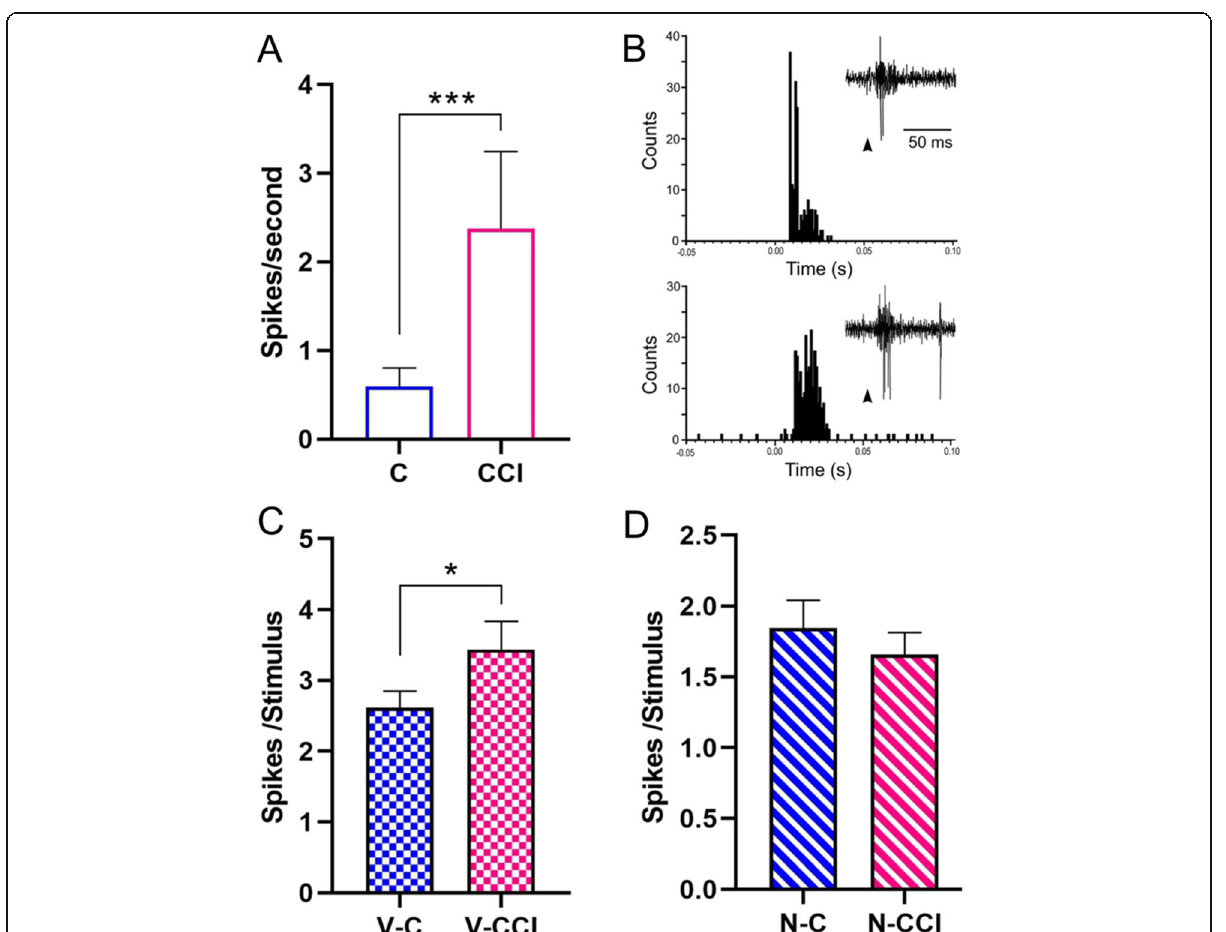
Fig. 3 Changes in spontaneous and input-evoked activity of TCC neurons after CCI-IoN. ( a ) Frequency of spontaneous discharges increased four- fold in CCI-IoN animals (C, control group; CCI, CCI-IoN group). ( b ) Representative PSTHs of vibrissal responses (50 stimuli) in a control case (upper plot) and in a CCI-IoN rat (lower plot). Insets show raw data examples; arrowheads indicate stimulus onset. The response was higher in the CCI- IoN rat. ( c ) Plot of the mean vibrissal response in control and in CCI-IoN animals. The response was greater in CCI-IoN animals. ( d ) The response to GON stimulation did not differ significantly between control and CCI-IoN animals. V-C, vibrissal response in control animals; V-CCI, vibrissal response in CCI-IoN animals; N-C, GON response in control animals; N-CCI, GON response in CCI-IoN animals; * p < 0.05; *** p <